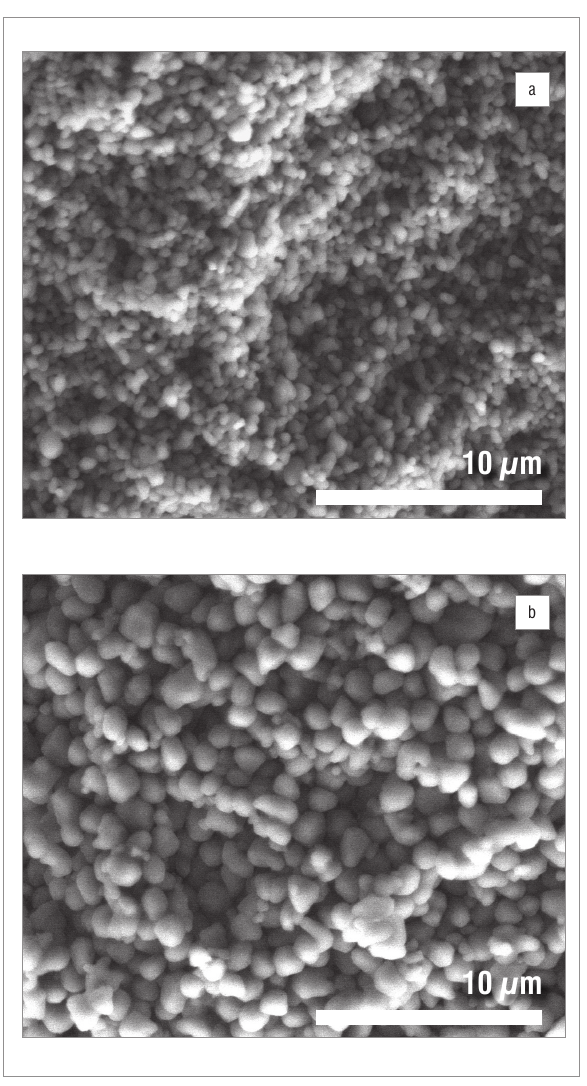
Figure 5: X-ray diffraction results of the mordenite framework inverted (MFI)-coated ceramic